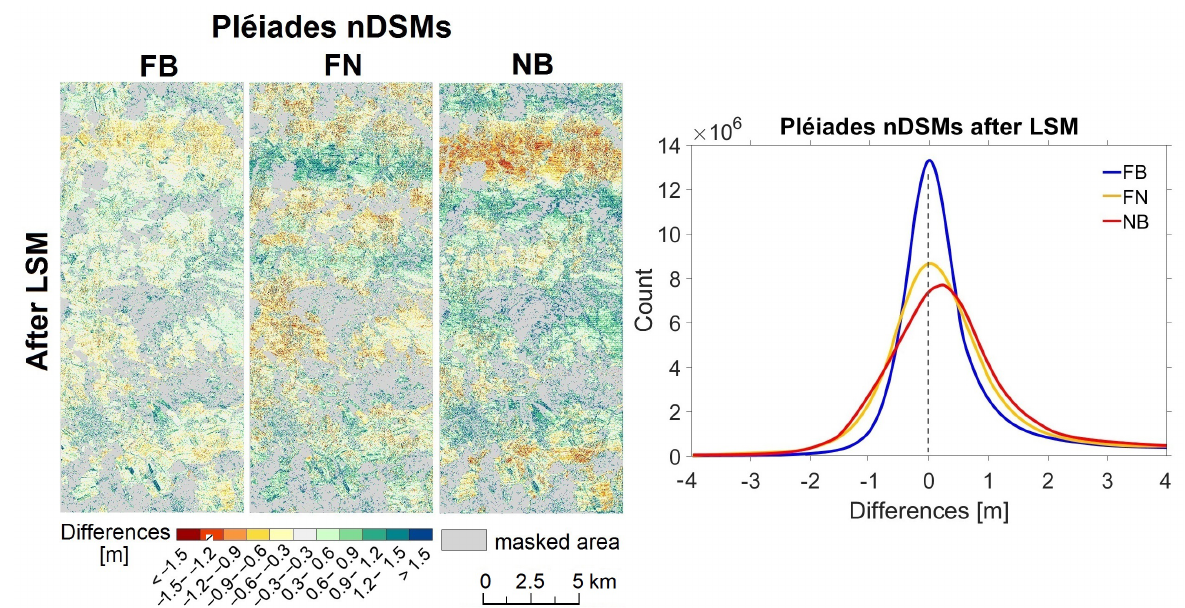
Figure 13. Pléiades nDSMs (RPC refinement with 43 GCPs) for open areas after global LSM. Color- coded height differences (masked areas are shown in grey) with corresponding frequency distribution of height discrepancies for all combinations (to be compared with Pléiades nDSMs before global LSM in Figure 12a).